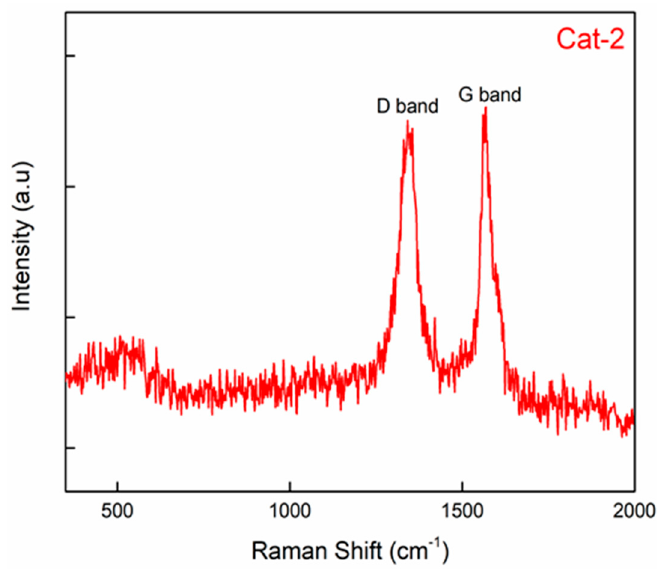
Figure 8. Raman spectra of deposited carbon on the catalyst.